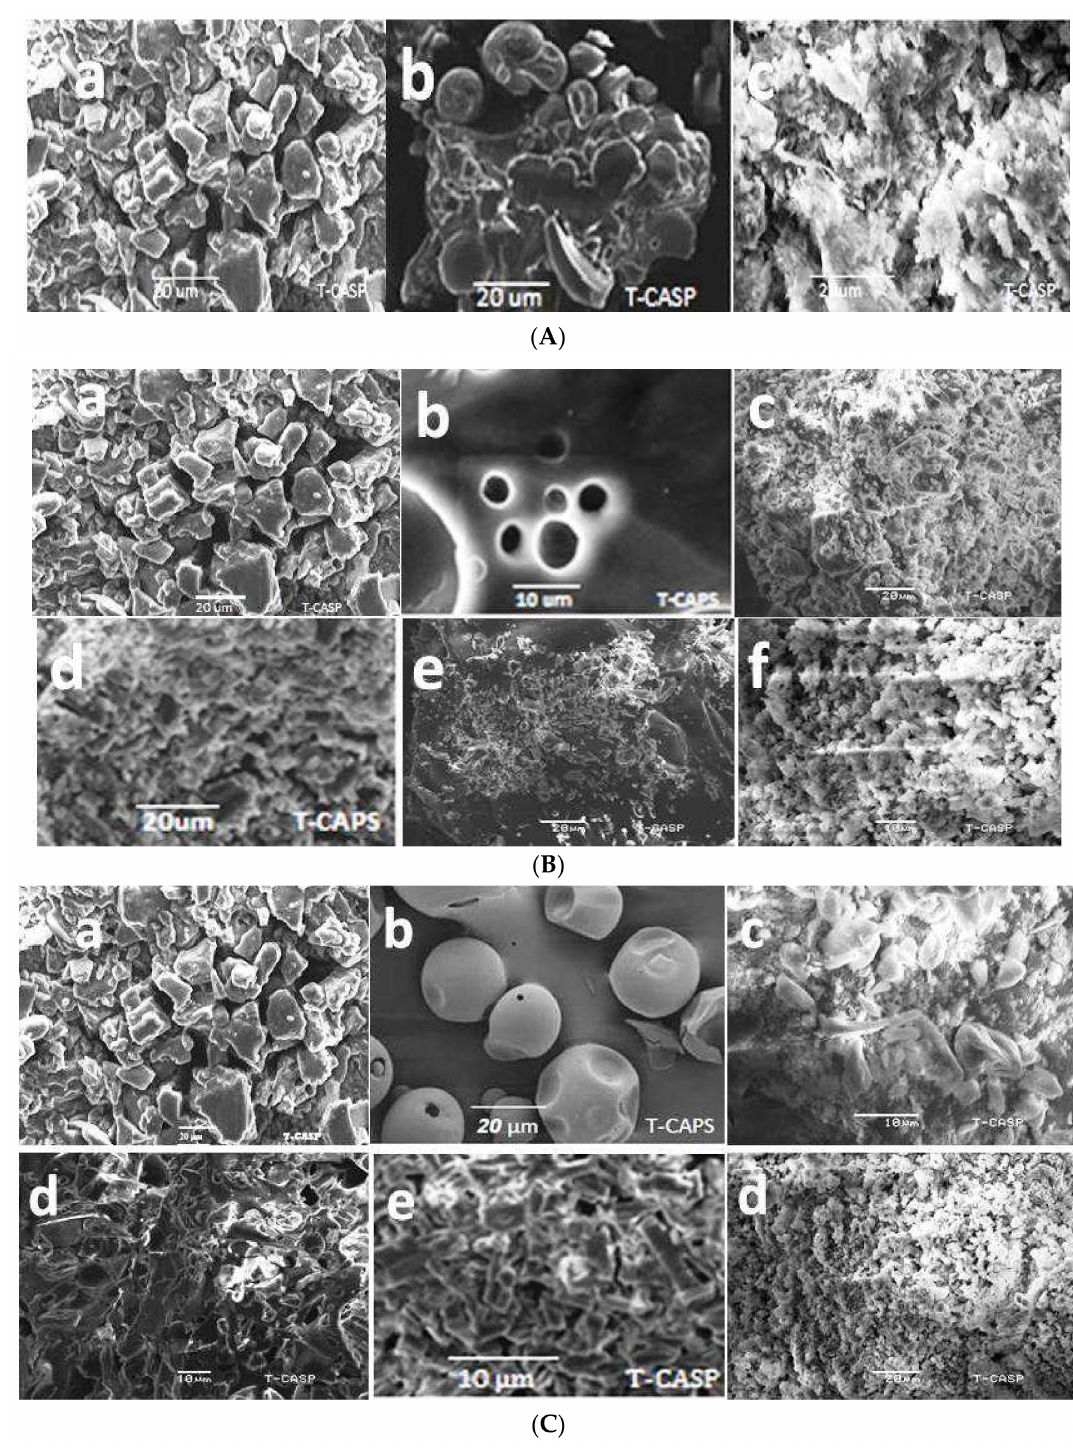
Figure 4. ( A ) SEM pictures of (a) DEX, (b)HP β CD and (c) 1:4 DEX:HP β CD. ( B ) SEM pictures